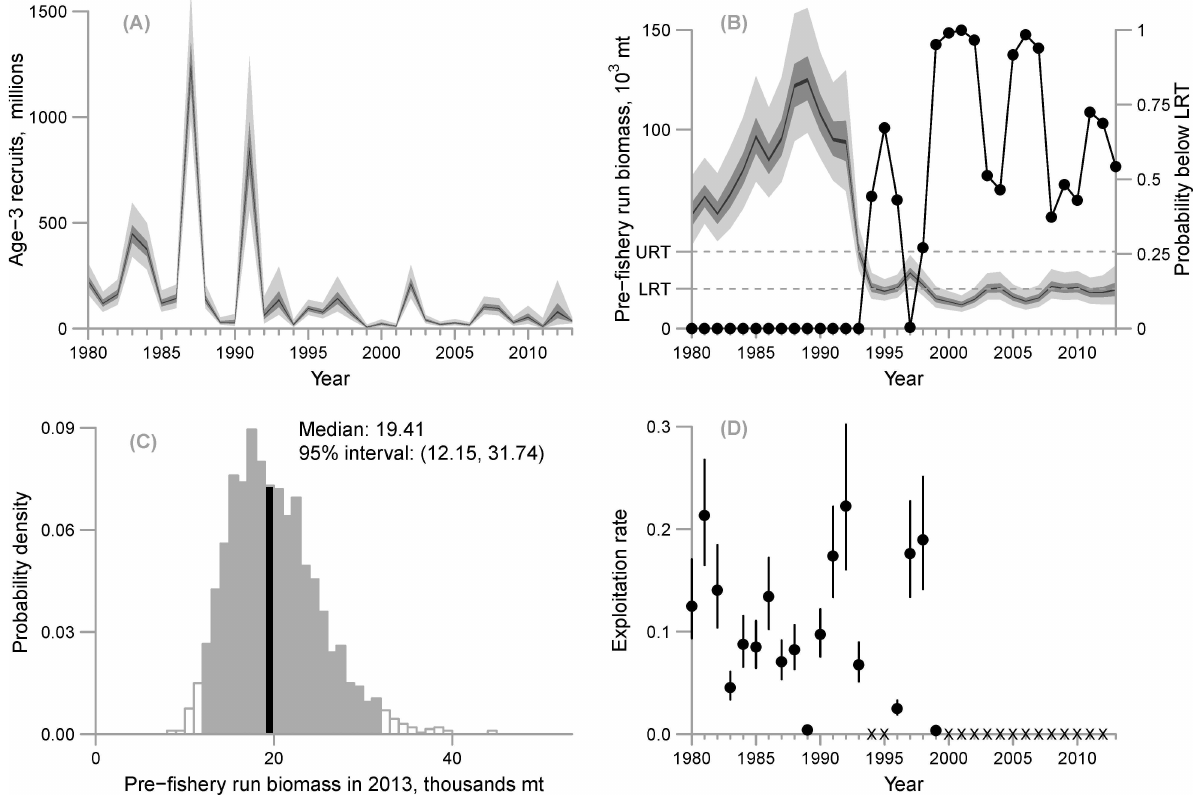
Fig 7. (A) Estimated recruitment at age-3 (posteriorintervals; light gray = 95% interval, darker gray = 50% interval, black = 5% interval), (B) estimated pre-fisherybiomass (posteriorintervals; light gray = 95% interval, darker gray = 50% interval, black = 5% interval) and the probability that pre-fisherybiomass is belowthe lower regulatorythreshold(LRT) of 22,000 short tons (19,958 mt) (connected black points) with the upper regulatorythreshold(URT: 42,500 short tons, 38,555mt) shown for reference, (C) posterior distributionof estimated pre-fishery biomass for 2013 with the 95% credible interval (light grey) and the median(black) shown,and (D) posteriormedianexploitation rates (black points) with 95% posteriorintervals(segments)—“X” characters representyears the fishery was